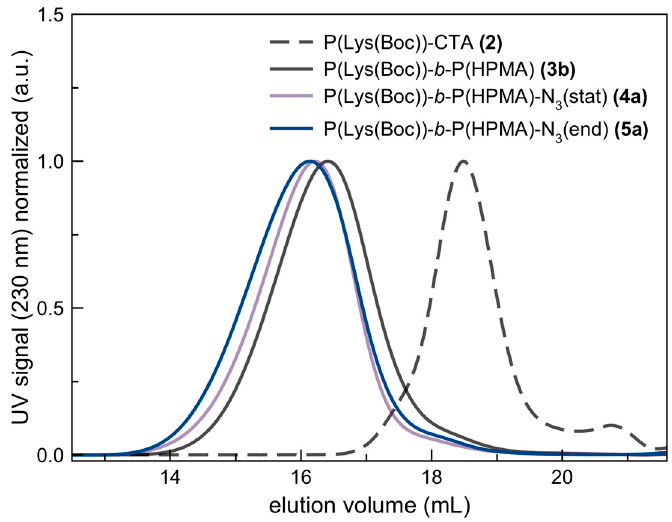
Figure 1. GPC in HFIP of P(Lys(Boc))-CTA (2), P(Lys)- b -P(HPMA) (3b), P(Lys)- b -P(HPMA)-N 3 (stat) (4a) and P(Lys)- b -P(HPMA)-N 3 (end) (5a).